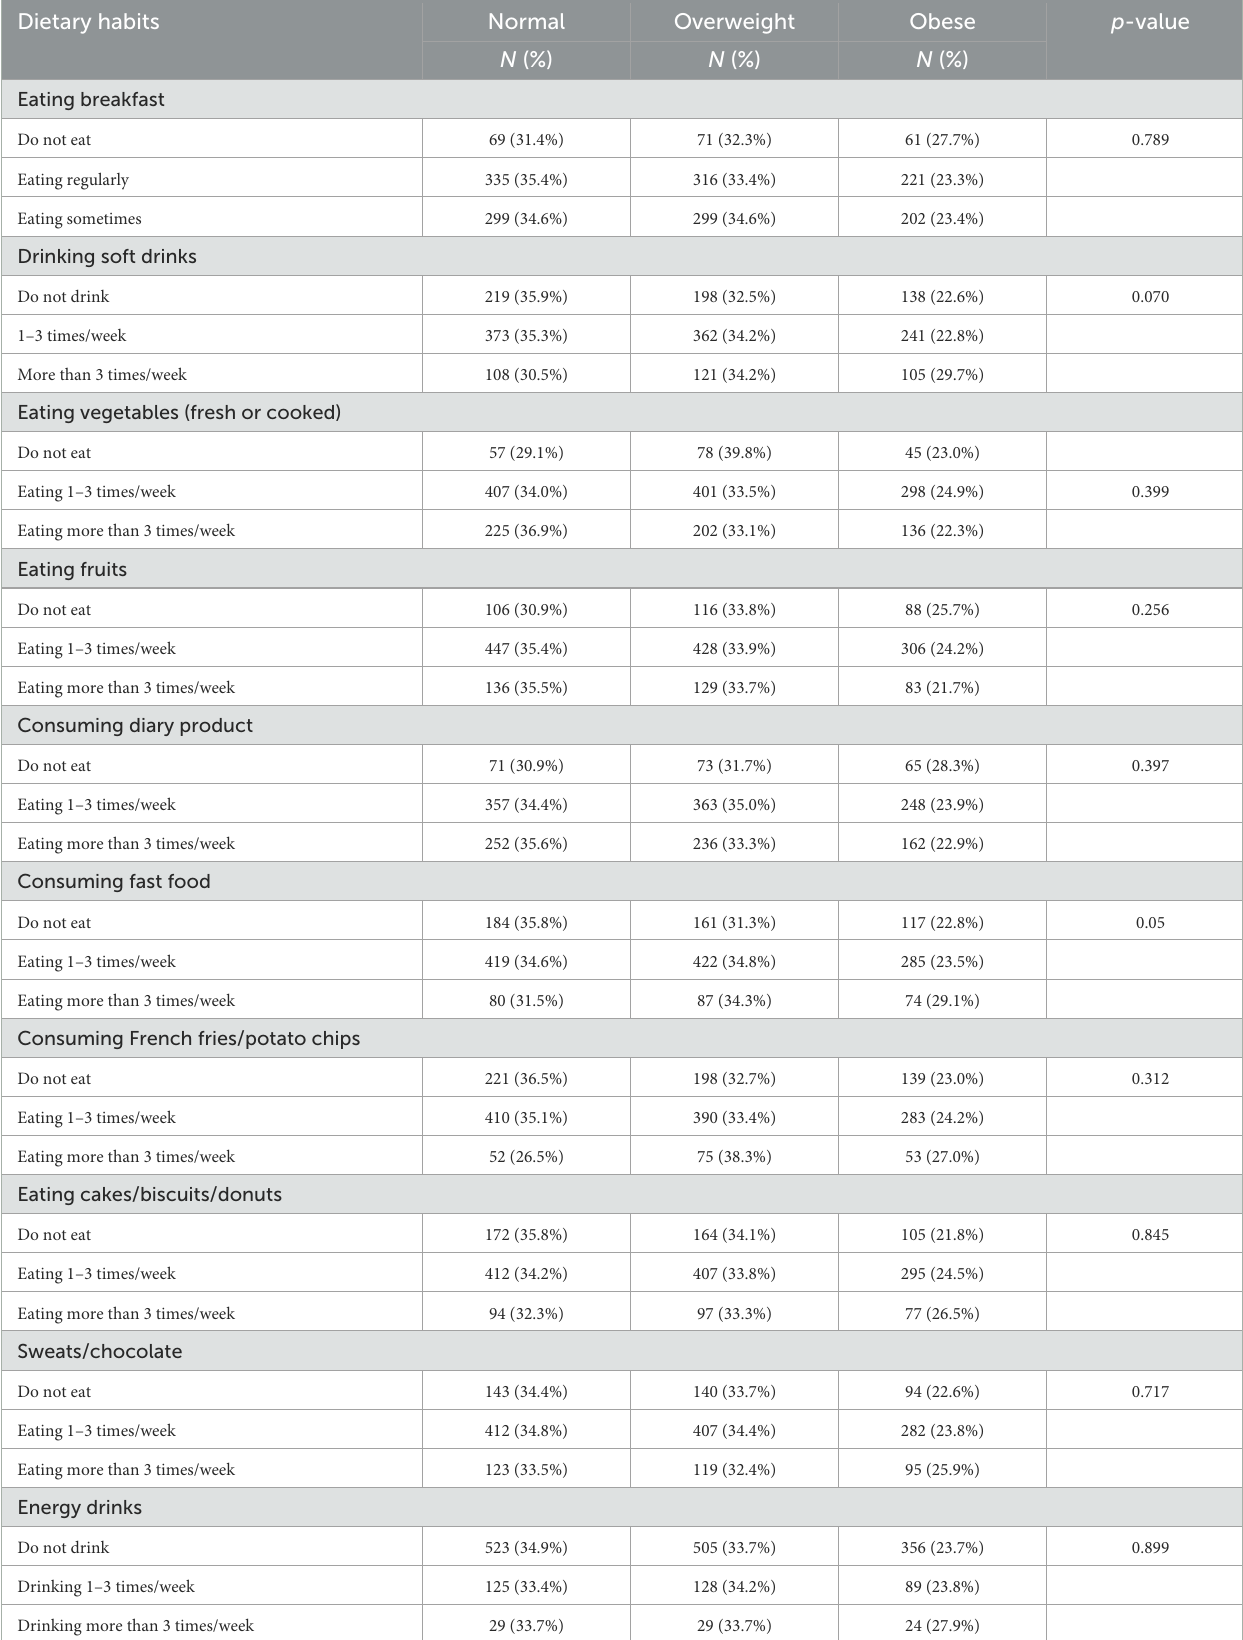
TABLE 2 Correlation of dietary habits with different BMI categories (normal, overweight, and obese). Dietary habits Normal Overweight Obese p